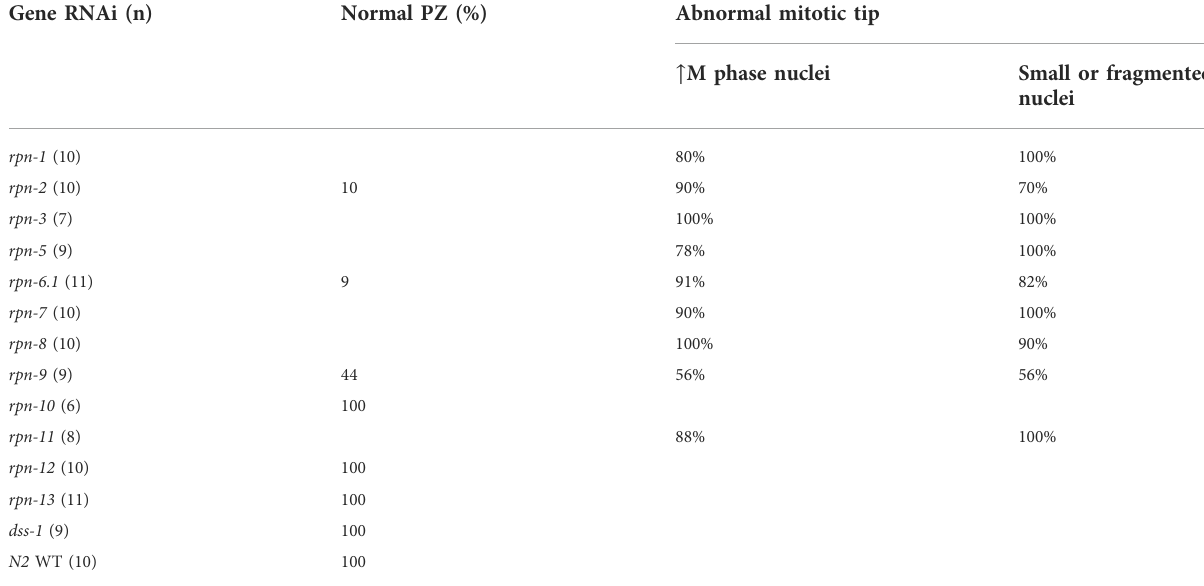
rpn-13, and dss-1/rpn-15 did not alter PZ nuclear size or